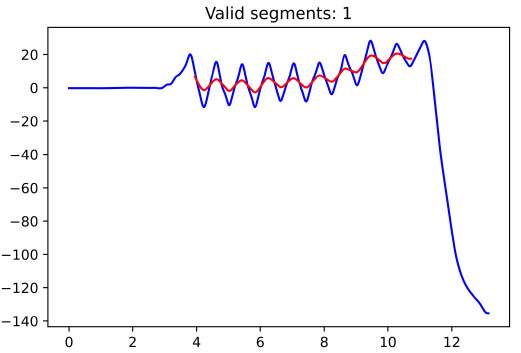
Figure A1. A participant in the HC group, fast walk experiment; in blue, original pelvic rotation values; in red, smoothed values, during walking phase.